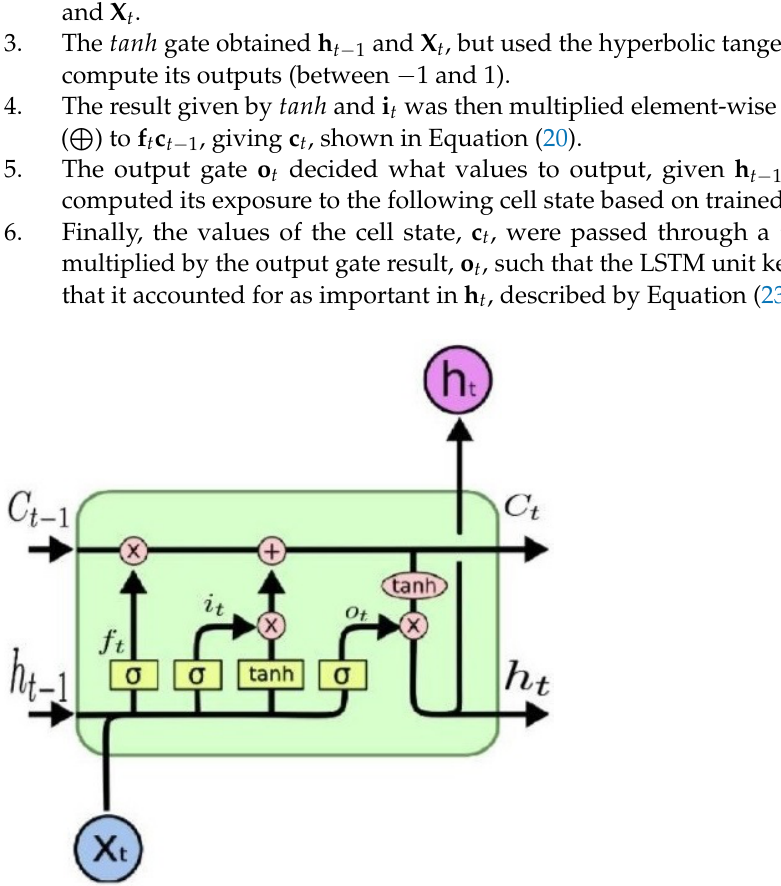
Figure 1. The LSTM unit kept a cell state throughout its operations, which served as input in the next time step. It also output h t , which supplemented the input X t in the following time step. From Olah